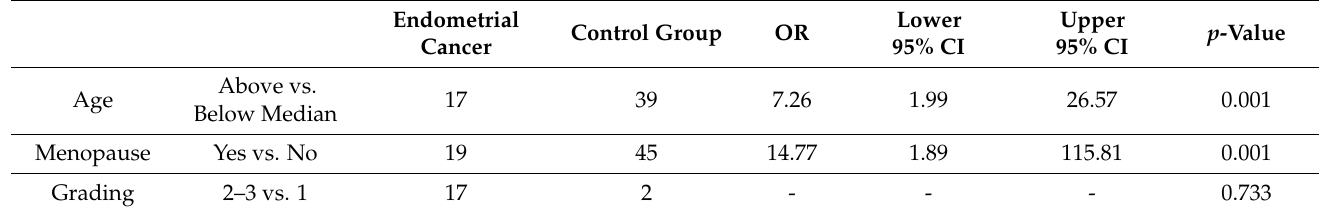
Table 4. Influence of the assessed variables on endometrial cancer